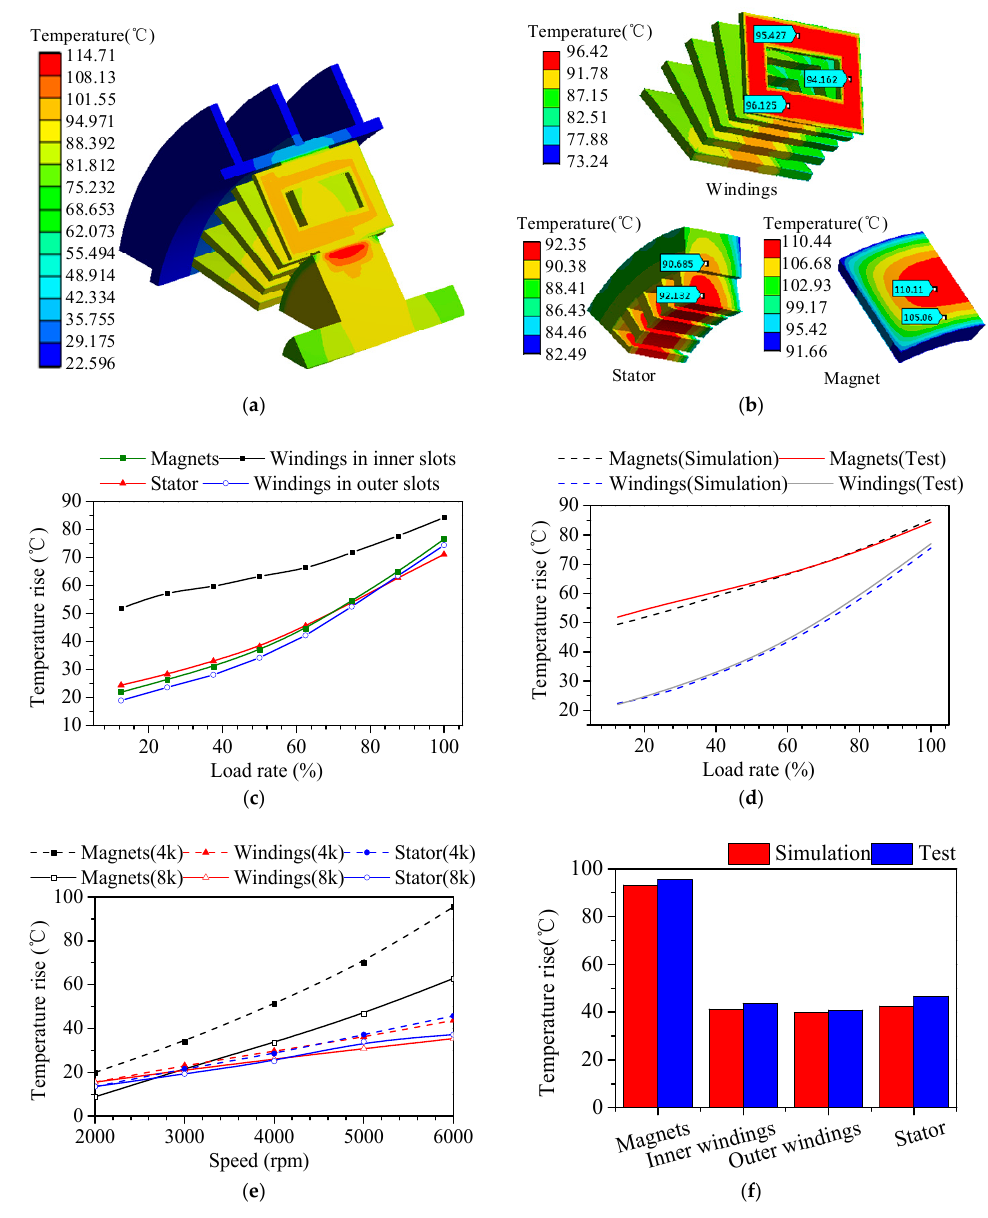
Figure 15. Distribution of temperature rise of, ( a ) entire prototype; ( b ) different components of the prototype; ( c ) variation of the tested temperature rises with load rates at 6000 rpm; ( d ) comparison of the test and simulation temperature rises; ( e ) comparison of the tested temperature rises between the carrier frequencies of 4 kHz and 8 kHz; ( f ) comparison of the test and simulation temperature rises with carrier frequencies of 4 kHz.